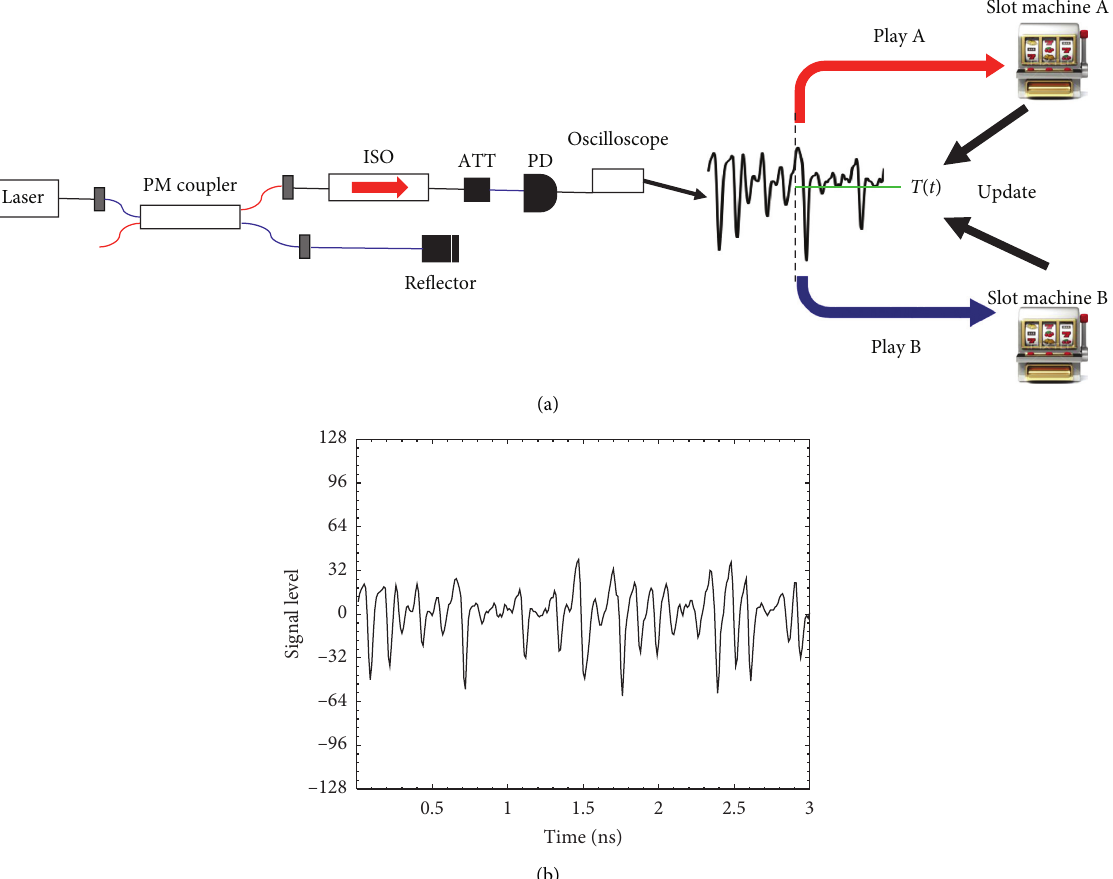
Figure 1: The architecture of laser chaos decision maker. (a) Experimental configuration of laser chaos-based reinforcement learning. (b) Temporal waveform of the laser chaos time